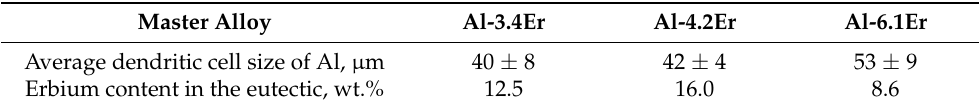
Table 1. Results of the average size calculation of the Al dendritic cell and the erbium content in the eutectic region of the master alloy microstructure. Erbium content in the eutectic, wt. % Average dendritic cell size of Al, µ m Erbium content in the eutectic, wt.%